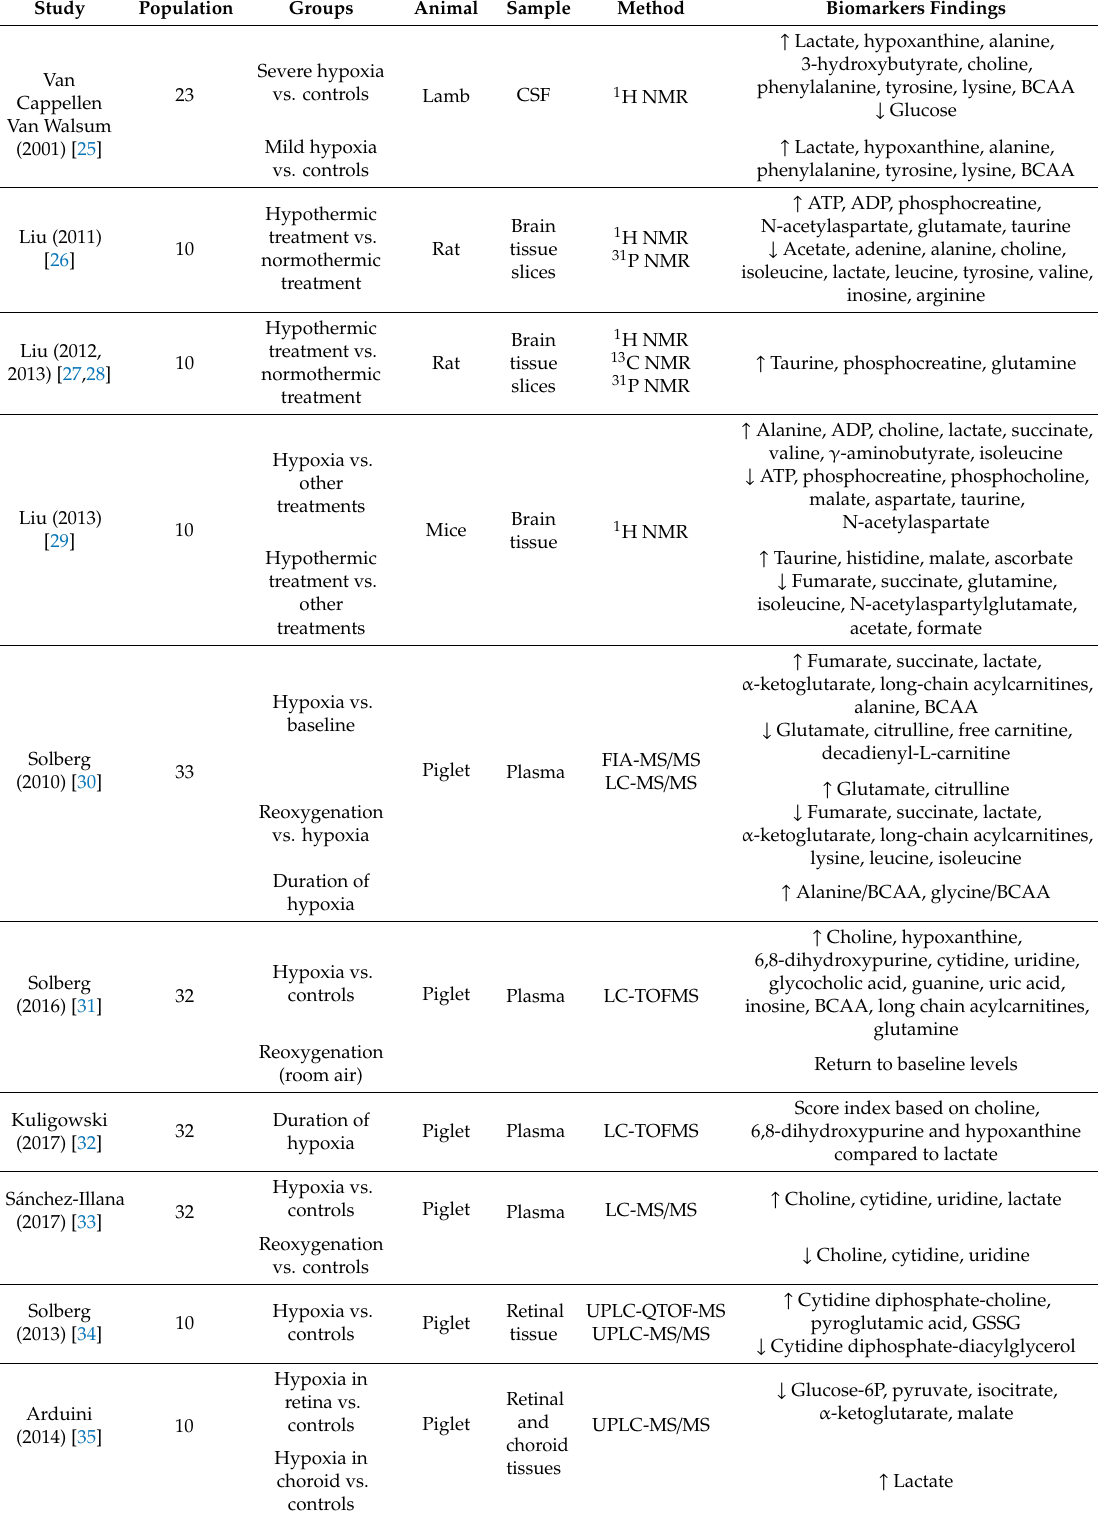
Table 1. Metabolomics studies performed on animal